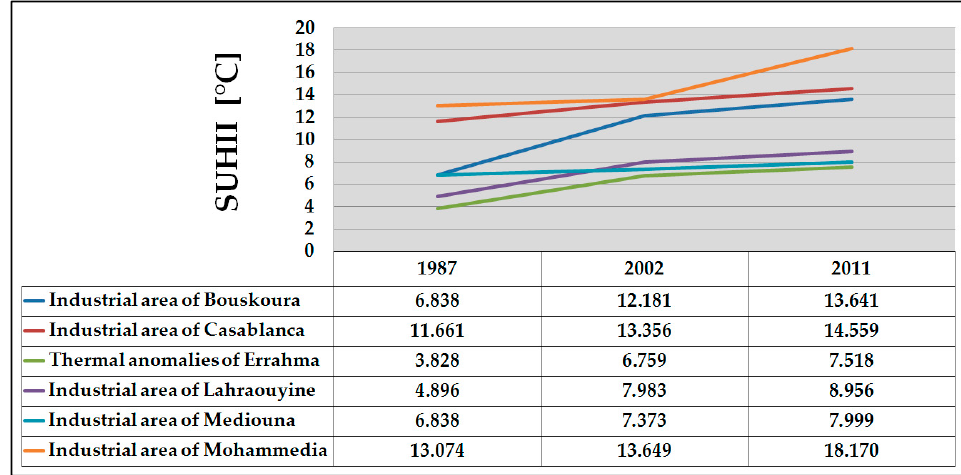
Figure 9 . Variation of the maximum SUHII during winter from 1987 to 2011 (obtained from maximum winter SUHII in 1987, 2002 and 2011).